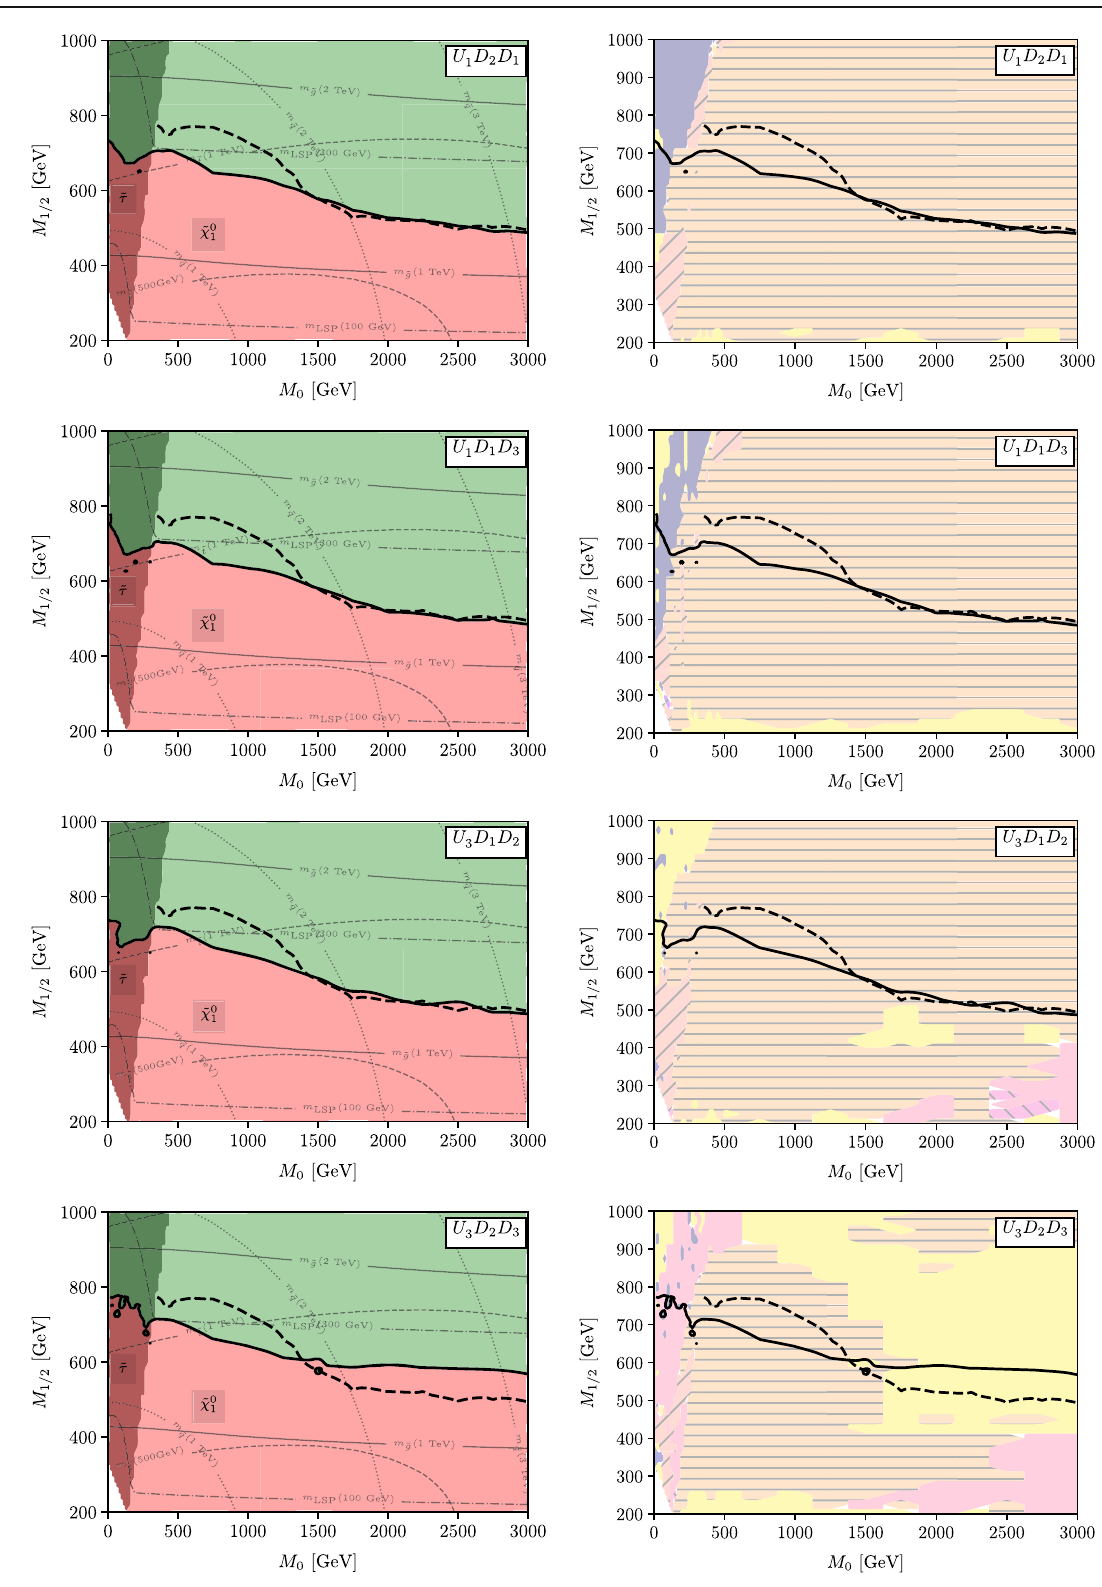
,λ (cid:4)(cid:4) ,λ (cid:4)(cid:4) and λ (cid:4)(cid:4) 121 131 312